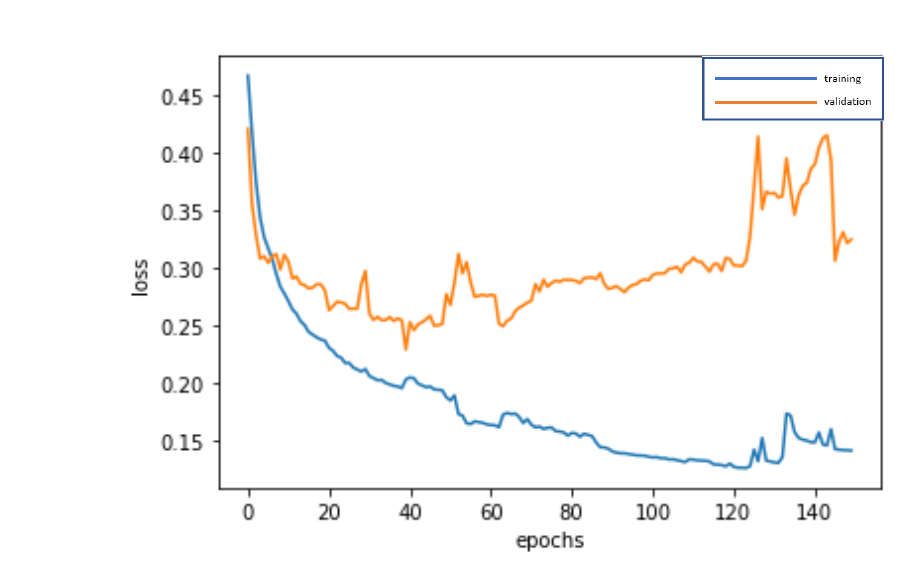
Figure 12. Graph of loss function of the RNN modeling.